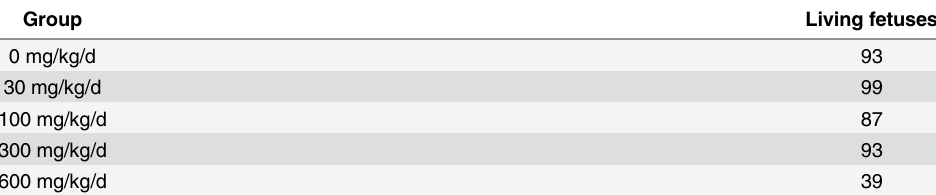
Table 2. The number of living fetuses.